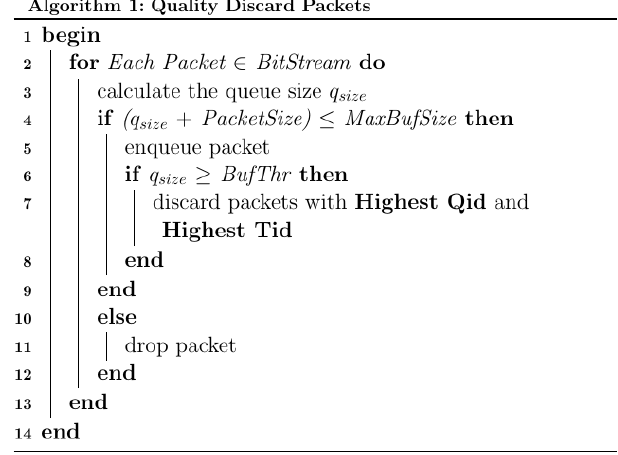
Figure 2. Quality Discard Packets scenario